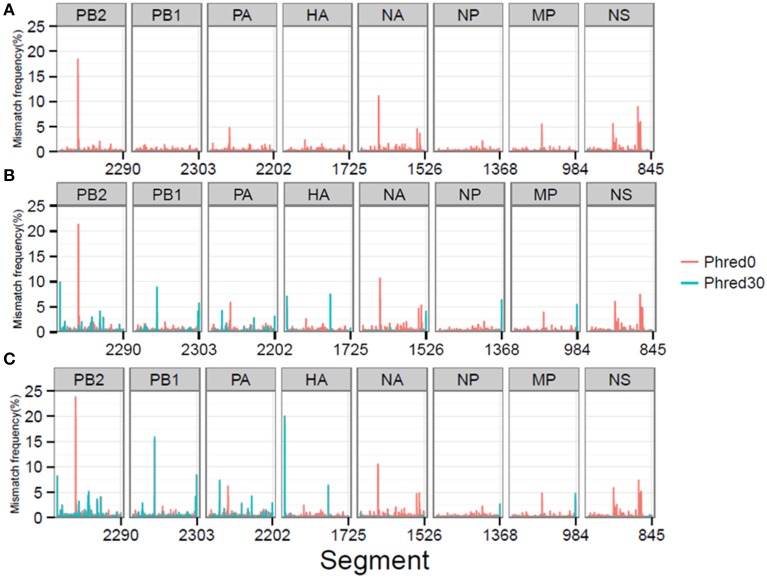
MMF's differ at specific reference genome positions depending on the per nucleotide phred quality cutoff for the plasmid pool (A), RT-PCR 1 (B), and RT-PCR 2 (C) samples.